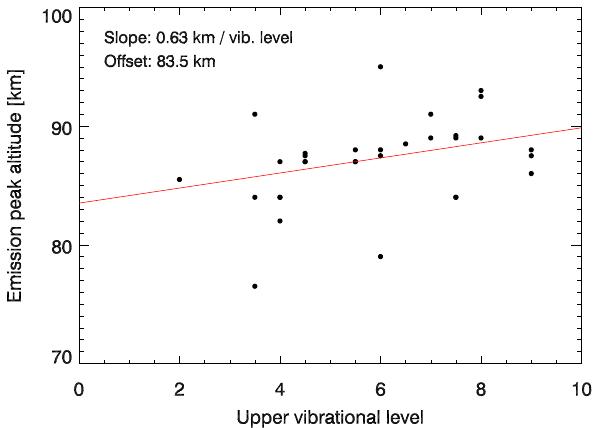
Fig. 5. Dependence of OH( ν 0 , ν 00 ) emission peak altitude on the upper vibrational level ν 0 as extracted from Table V in Baker and Stair (1988). See text for a detailed description of the data screening applied.